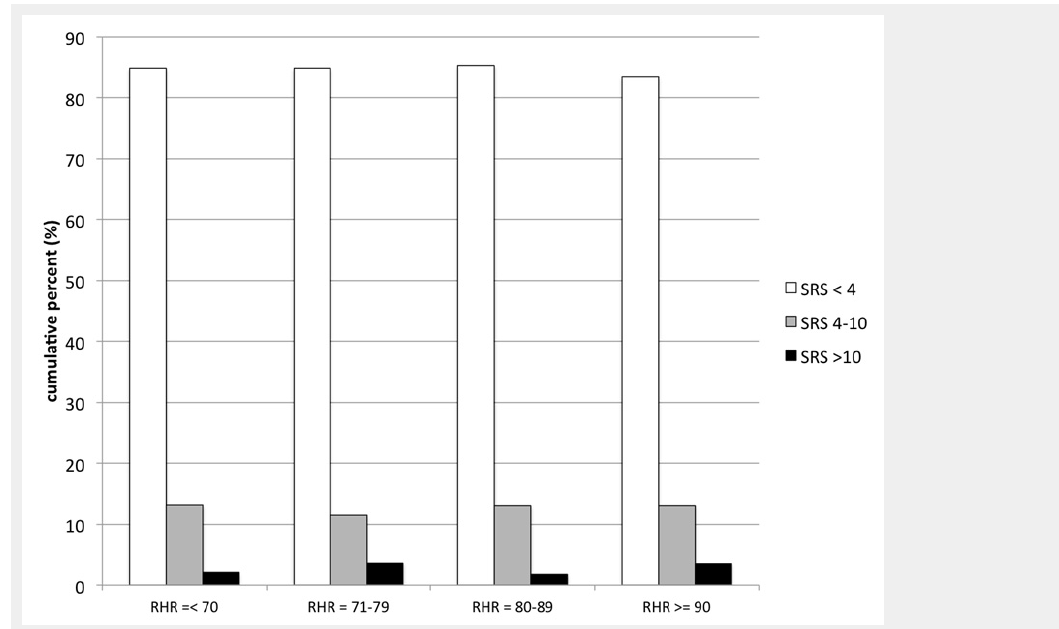
Figure 2 Graphics illustrating the interrelationship between the quartiles of resting heart rate (RHR in bpm) and the extent of myocardial scar (SRS) as assessed by MPS. Note that RHR was related neither to severity of myocardial ischaemia (p = 0.798), nor to the extent of myocardial scar (p =